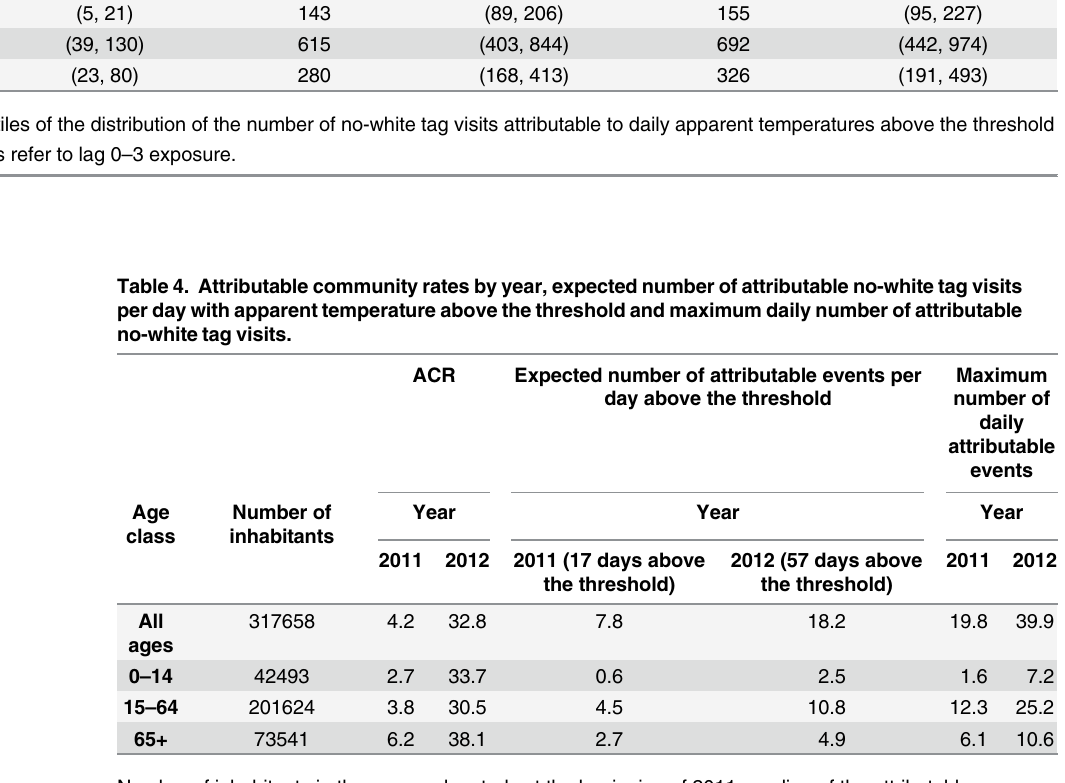
Median and 10 th and 90 th percentiles of the distribution of the number of no-white tag visits attributable to daily apparent temperatures above the threshold in 2011, 2012 and total. All results refer to lag 0 – 3 exposure.